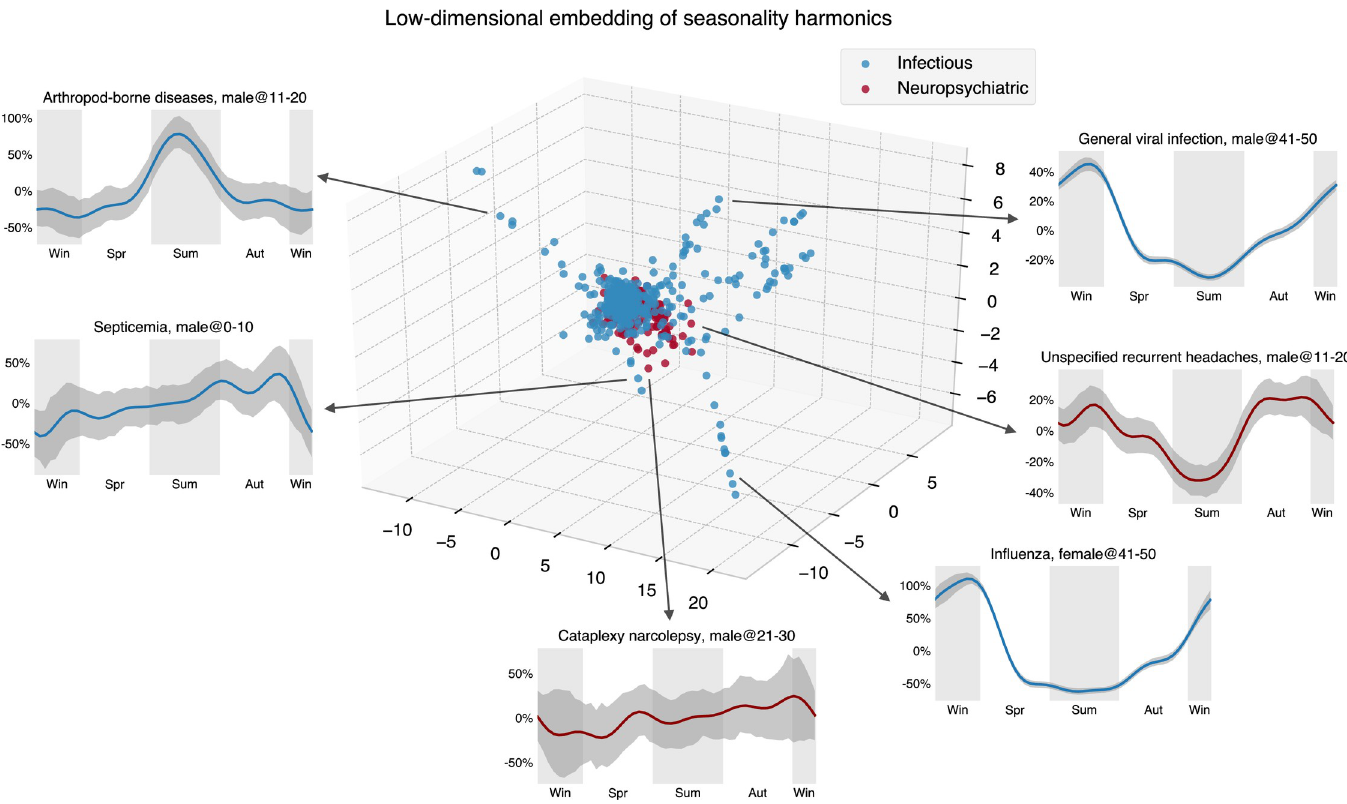
Fig 5. The embedding of uncorrected seasonality curves in a low-dimensional space suggests the homogeneity of the psychiatric diseases’ seasonal variation. We used the Isomap method to obtain a low-dimensional seasonality embedding of the first 10 Fourier harmonic base estimates � p Expressions (15) and (16)). Compared to the infectious diseases, we can see that the embeddings of psychiatric disease harmonics concentrate in a smaller space, implying the relative homogeneity of their seasonality. The data underlying this figure can be found in